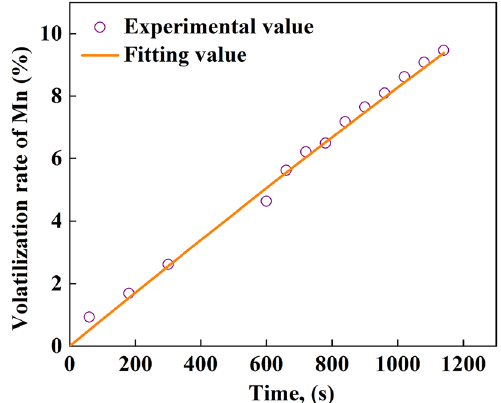
Figure 5: Comparison between the volatilization rate of manganese in experiment and that obtained by calculation.